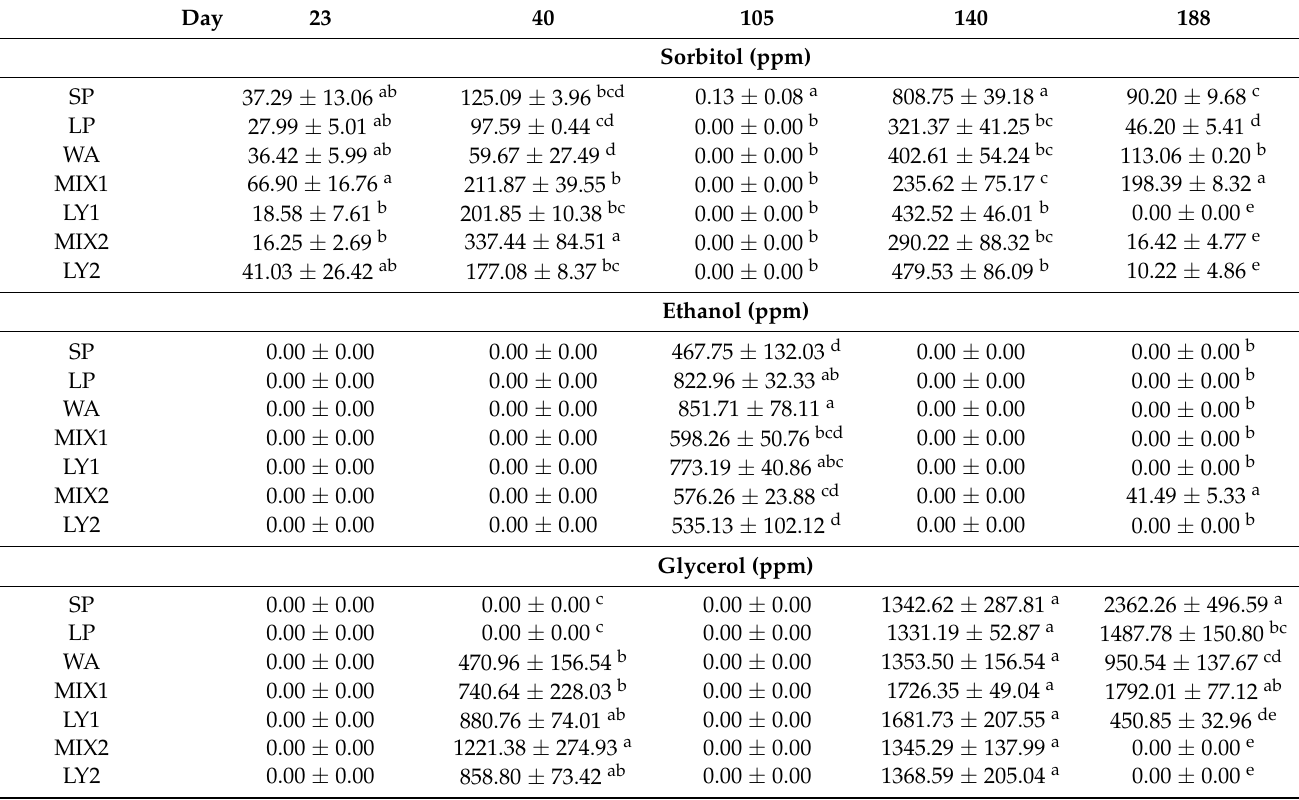
(Figure 2C,D): mean values of mannitol were 2405.53 ppm on the 16th day and 1521.34